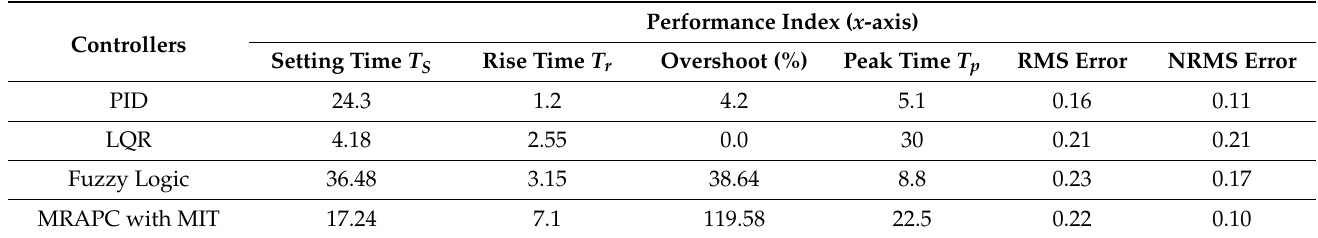
Figure 18. Yaw (ψ) Control result depending on step input for all control systems. Figure 18. Yaw ( ψ ) Control result depending on step input for all control systems. Table 6. Performance comparison of all controllers for the longitudinal position ( x